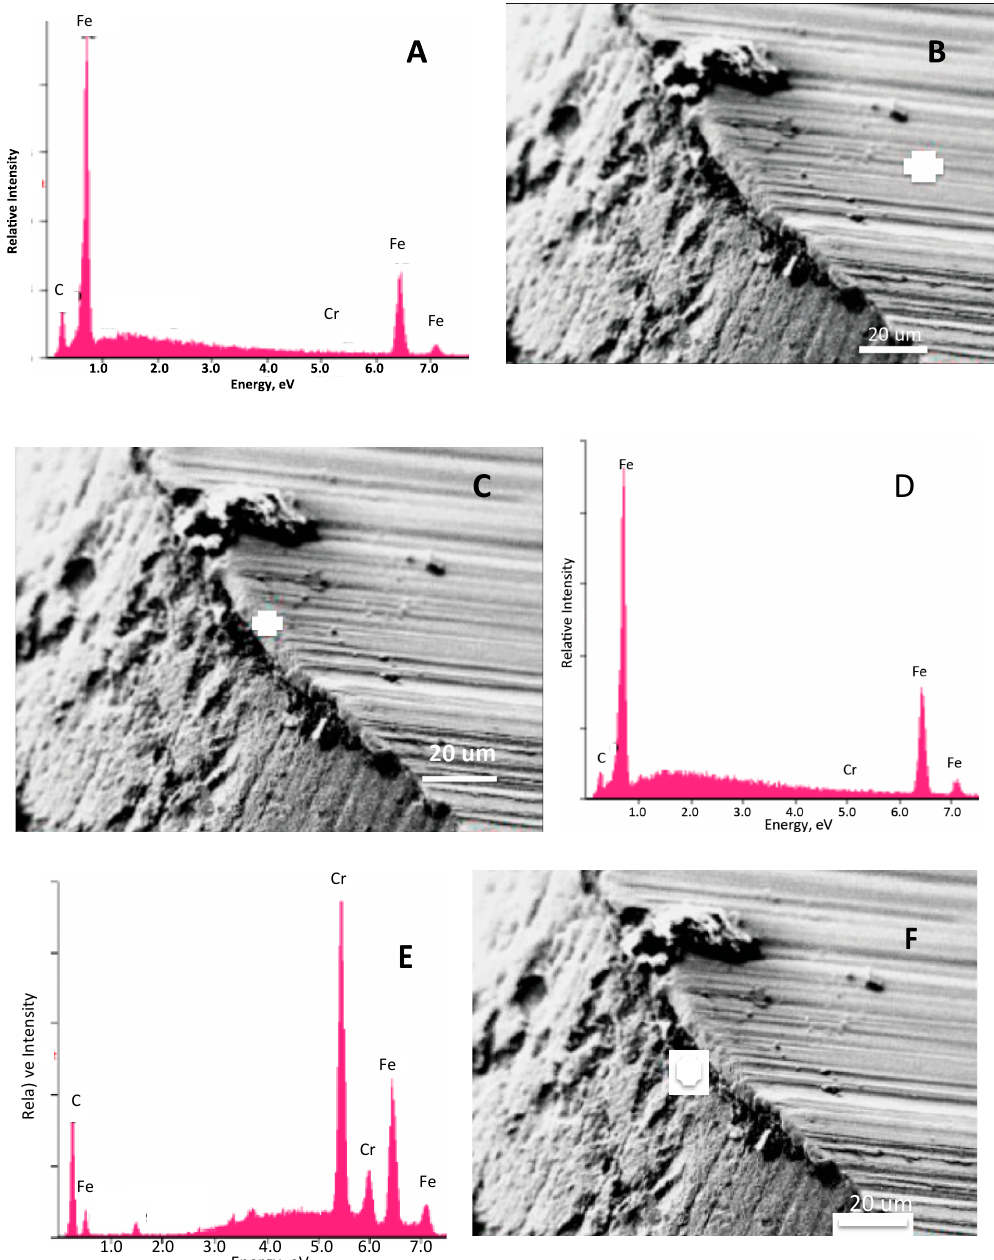
Figure 6. SEM Examination of Cut (no polish) Coated Iron Wire Prepared with Chrome Nitrate, 2 dips. ( A , B ) The EDXA signal ~50 microns from the surface layer is clearly iron with some carbon contamination. ( C , D ) The signal directly adjacent to the surface shows a virtually identical EDXA signal. ( E , F ) The surface layer is dominated by chrome. The iron observed in the EDXA presumed to be signal leakage from the dominant material, iron. It is notable that further probes of the surface, away from the cut area, shows virtually the same EDXA signal.